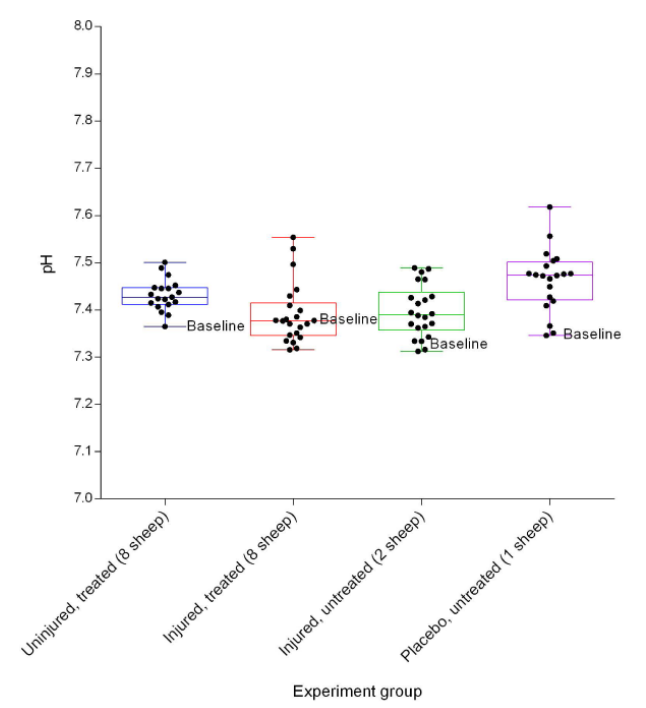
Figure 2. Pulmonary compliance (Mean ± SD) in smoke and non- smoke injured sheep that received extracorporeal life support as compared to that in untreated controls. Dotted lines represent error bar margins.